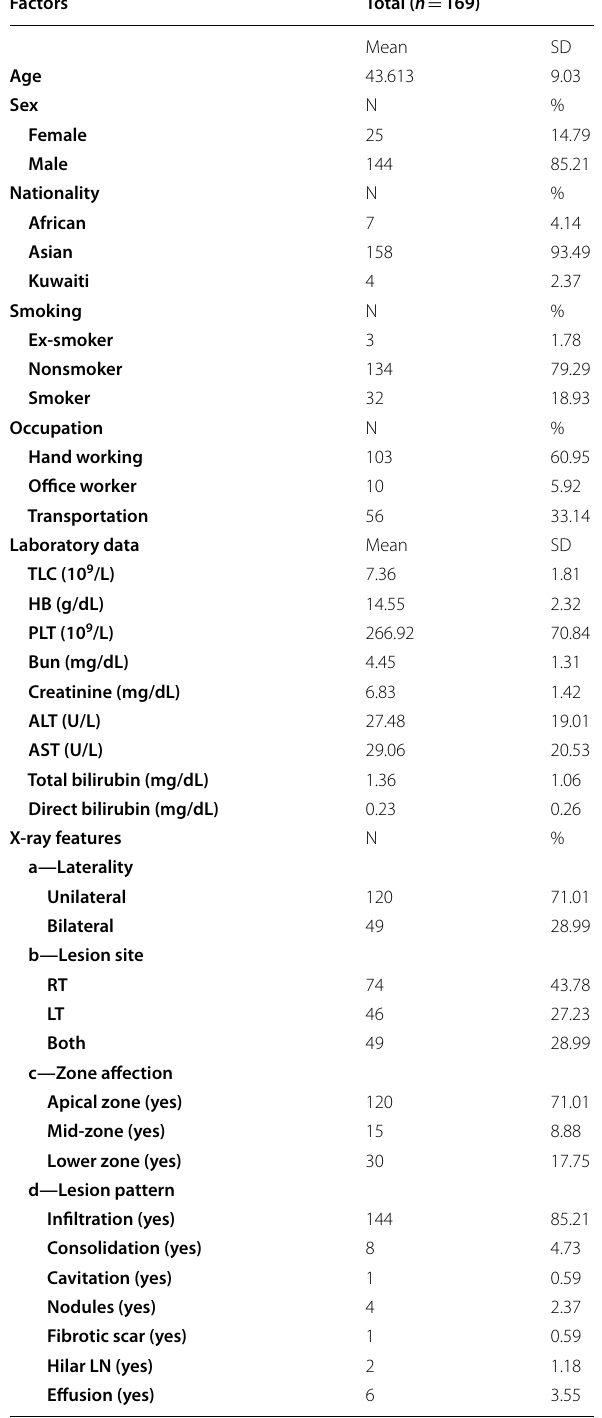
Table 1 General characteristics and clinical presentation of patients